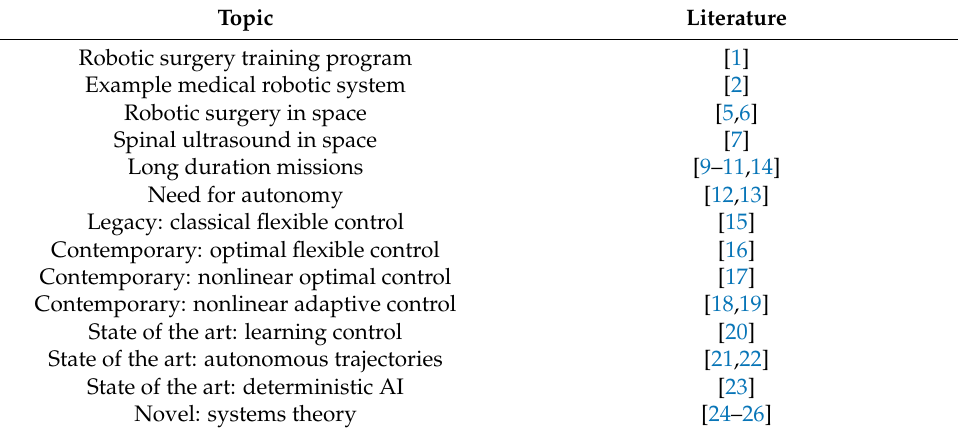
Figure 3. The results of Smeresky and Rizzo [20]: rotation degrees vs. time [seconds]. ( a ) results achieved using modern optimal methods; ( b ) results achieved using contemporary classical methods. ( c ) Smeresky’s and Rizzo’s [18] results achieved using their proposed methods. Comparisons such as this are deemed valuable, and this general methodology is adopted in this manuscript as a starting point. Table 1. Lineage of the reviewed literature 1 .